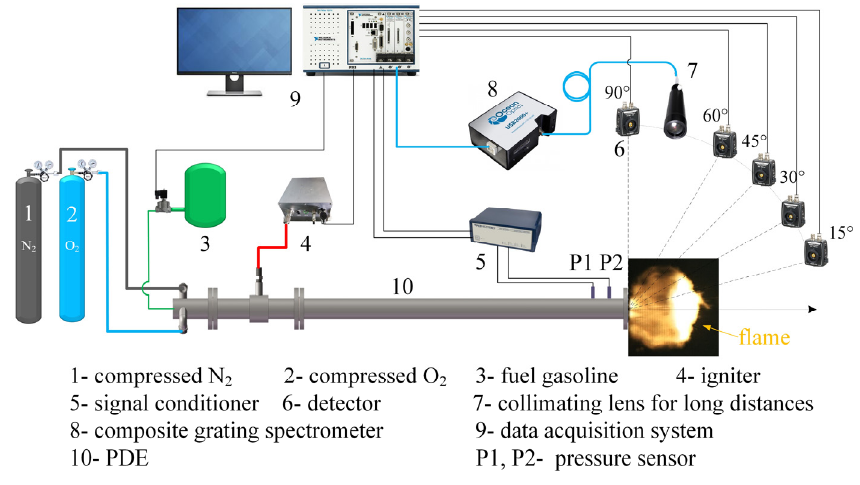
Figure 1. The schematic diagram of the experiment setup.